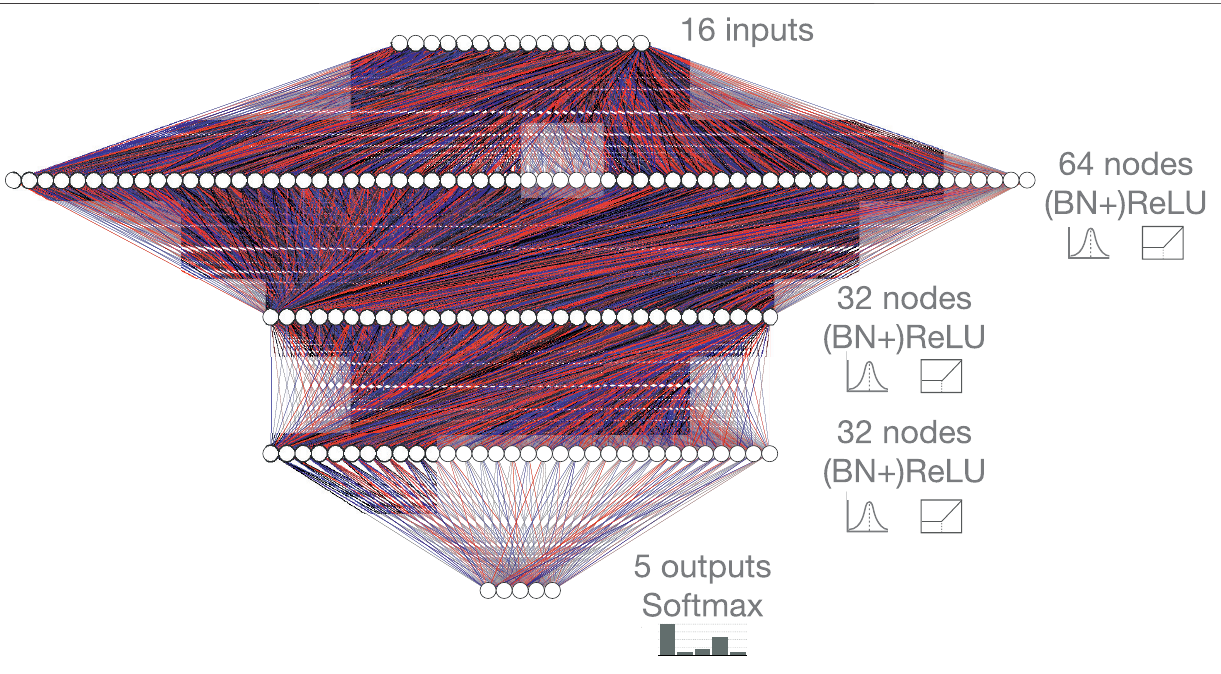
Frontiers in Arti fi cial Intelligence |